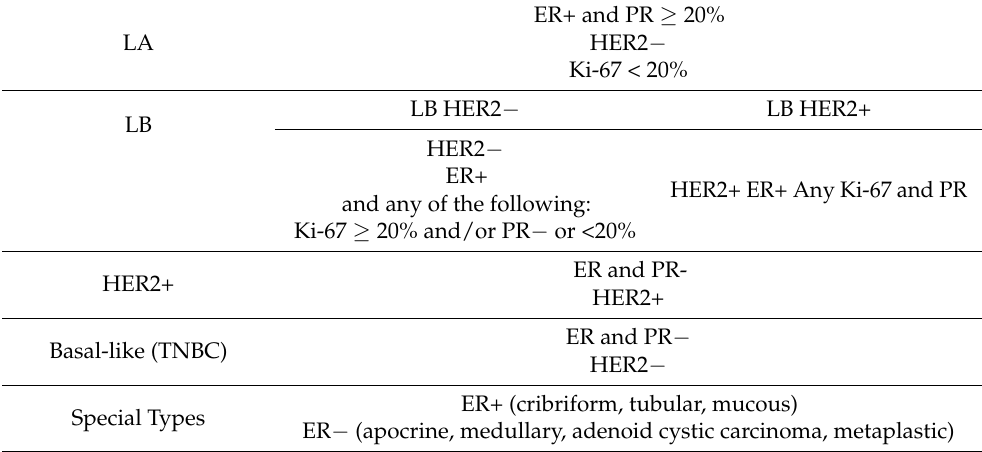
Table 3. Molecular classification of breast cancer.